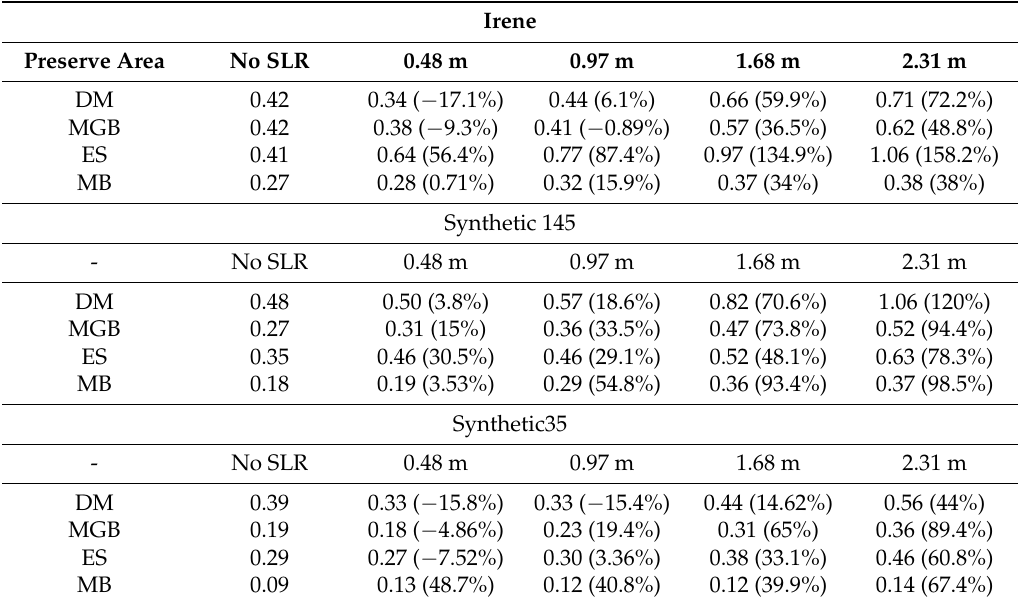
Table A4. Modeled data showing the maximum currents velocities for each Preserve Area. The percent increase in maximum currents velocities is shown in parenthesis. Irene